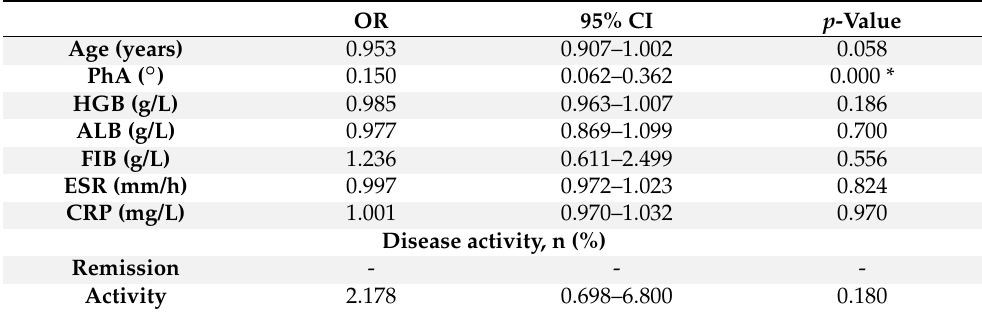
Table 3. Logistic regression analysis of predictors of malnutrition based on GLIM criteria in men.